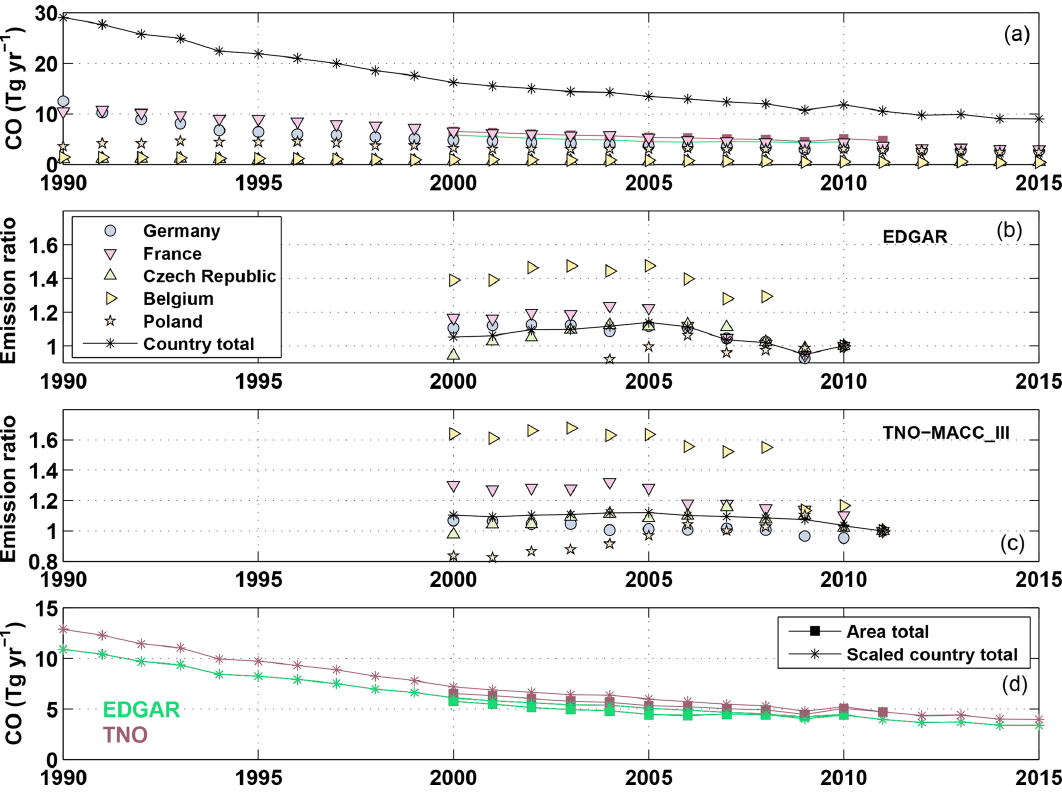
Figure A4. This four-panel plot shows the methodology for scaling the country-level reported emissions of CO to extrapolate the gridded inventory emissions to 2015. Panel (a) shows the CO emissions reported by the European Environment Agency (EEA) for the countries contained within the study area (Germany, France, Czech Republic, Belgium, Luxembourg, and Poland). The black stars with a joining line represent the summed total from the five countries. The EDGAR (green) and TNO-MACC_III (orange) inventories summed within the study area are plotted with squares joined by solid lines. Panel (b) shows the ratio between the individual country totals and the EDGAR area total, normalized to produce an emission ratio of 1 in 2010. The quantity with the least interannual variability in the ratio is from the country total (black stars with line). Panel (c) shows the ratio between the individual country totals and the TNO-MACC_III area total, normalized to produce an emission ratio of 1 in 2011. The quantity with the least interannual variability in the ratio is, again, from the country total. Panel (d) shows the scaled country total, normalized to produce the EDGAR CO emissions for 2010 and the TNO-MACC_III CO emissions for 2011. This permits us to compute a sensible emission for the study area through to